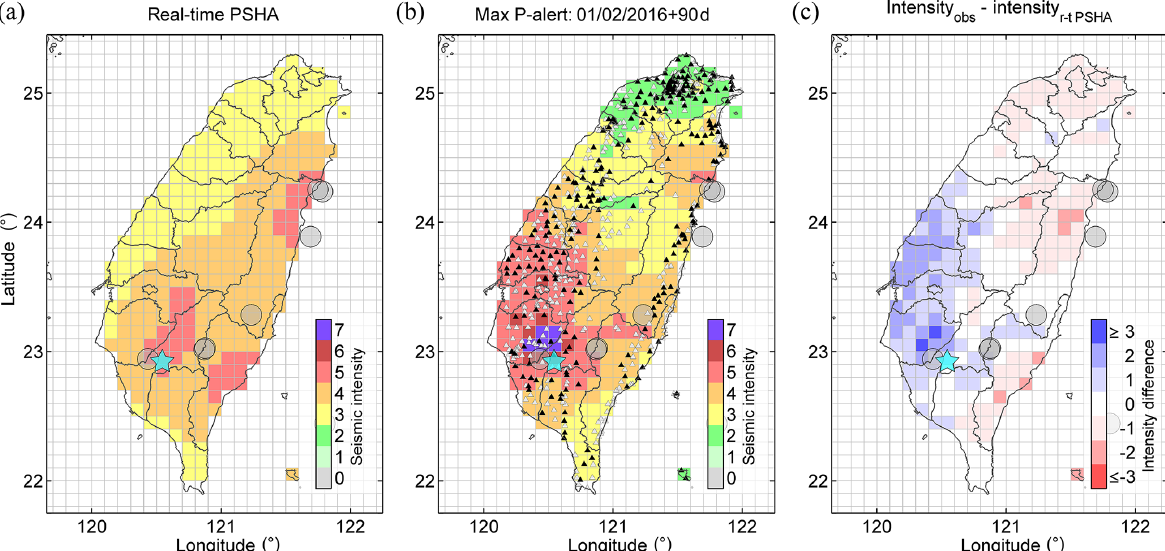
Figure 2. The 2016 Meinong earthquake. (a) Map of forecasted maximum seismic intensity by real-time PSHA. The forecasting interval of seismic intensity is 90d. (b) Map of maximum seismic intensity recorded by the P-alert network. Black and white triangles indicate the P-alert stations that we used and did not use, respectively, in the verification. (c) Difference in seismic intensity between the forecast and the record. The cyan star represents the Meinong earthquake, and the gray circles represent the earthquakes with magnitude M L ≥ 5 in this forecasting interval.